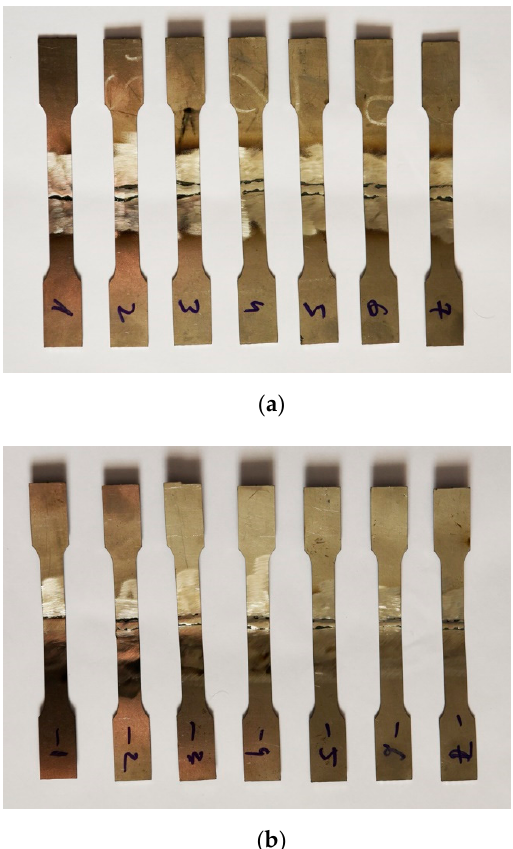
Figure 3. The specimens for the uniaxial tensile test. ( a )—one side welded specimens; ( b )—double side welded specimens.